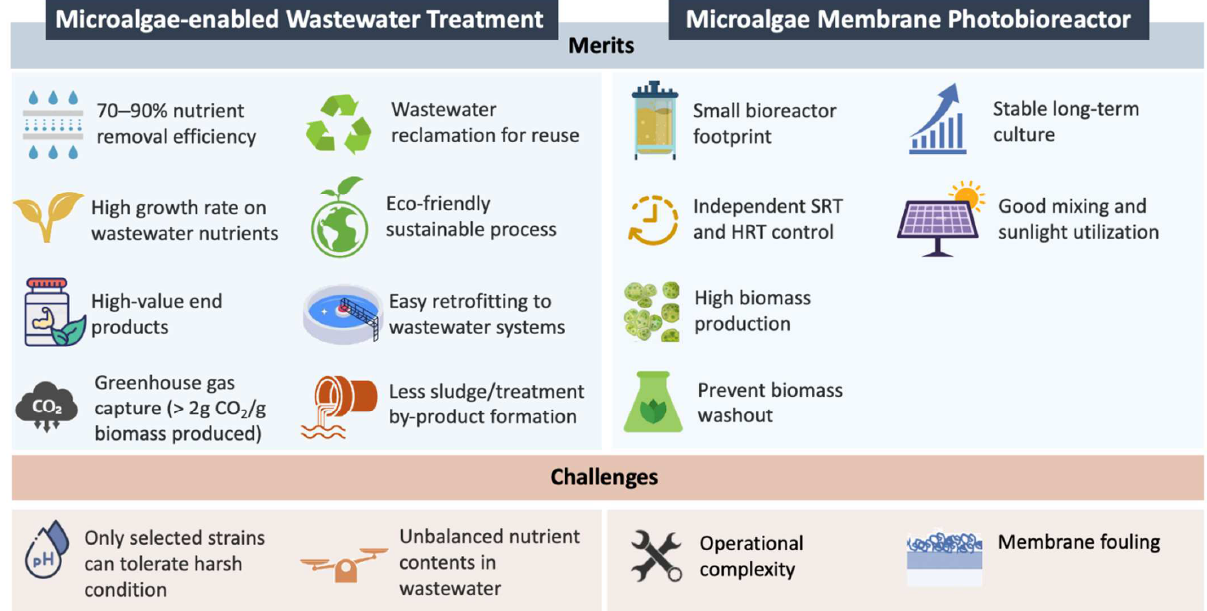
Figure 1. Summary of the merits and challenges of microalgae – enabled wastewater treatment .